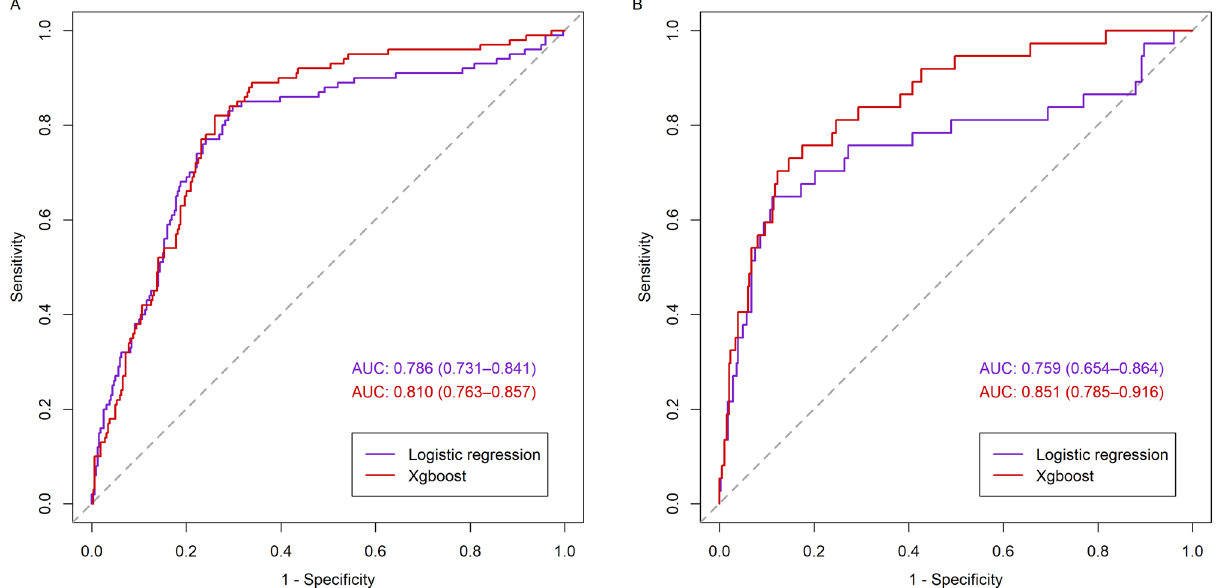
Figure 2. Receiver operating characteristic curves of the logistic regression and the XGBoost models for MAKE30 ( A ) and 90-day adverse outcomes ( B ) in the test set ( B ). AUC, area under the receiver operating characteristic curve. The figure was created using R 4.1.2 (https:// cran.r- proje ct. org).